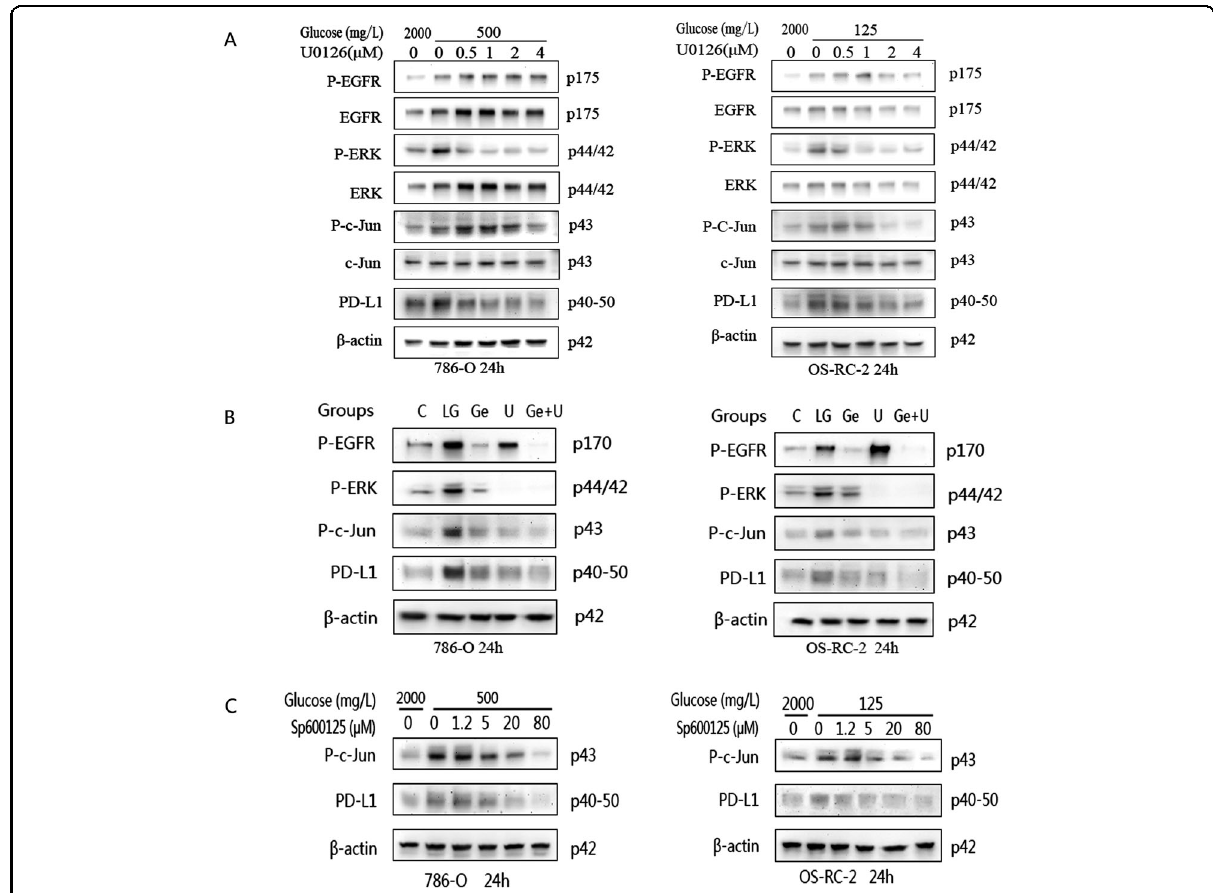
Fig. 5 The protein levels of EGFR, ERK, c-Jun and PD-L1 induced in the two cell lines were detected by western blot analysis after treatment with different intervention conditions for 24 h. A The expression levels of the target proteins were evaluated after the addition of the ERK inhibitor U0126 during low-level glucose cultivation. B After the addition of the EGFR inhibitor ge fi tinib (Ge), the ERK inhibitor U0126 (U) or the combined application of ge fi tinib and U0126 (Ge + U), the expression of each target protein was observed. C The expression levels of activated c-Jun and PD-L1 were increased by adding the c-Jun inhibitor SP600125 under low-glucose conditions. Independent experiments were performed in